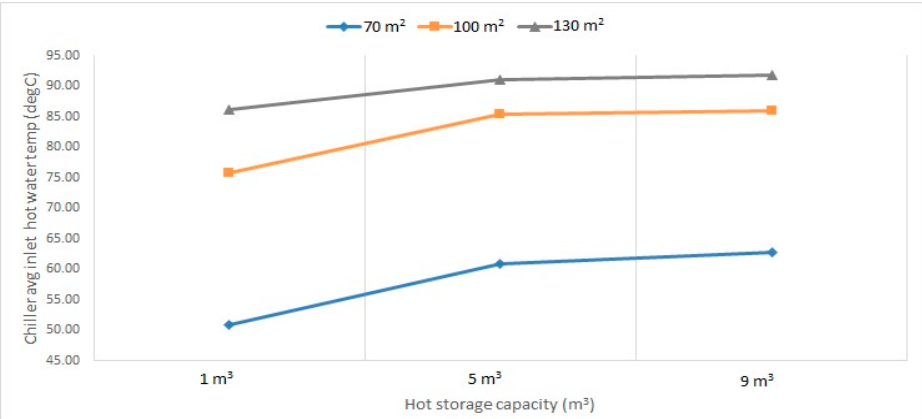
Figure 9. Chiller average inlet hot water temperature at 0.6 kg/s for different hot storage capacities and solar collector areas (collector–HW tank–chiller) pumps flow rates.